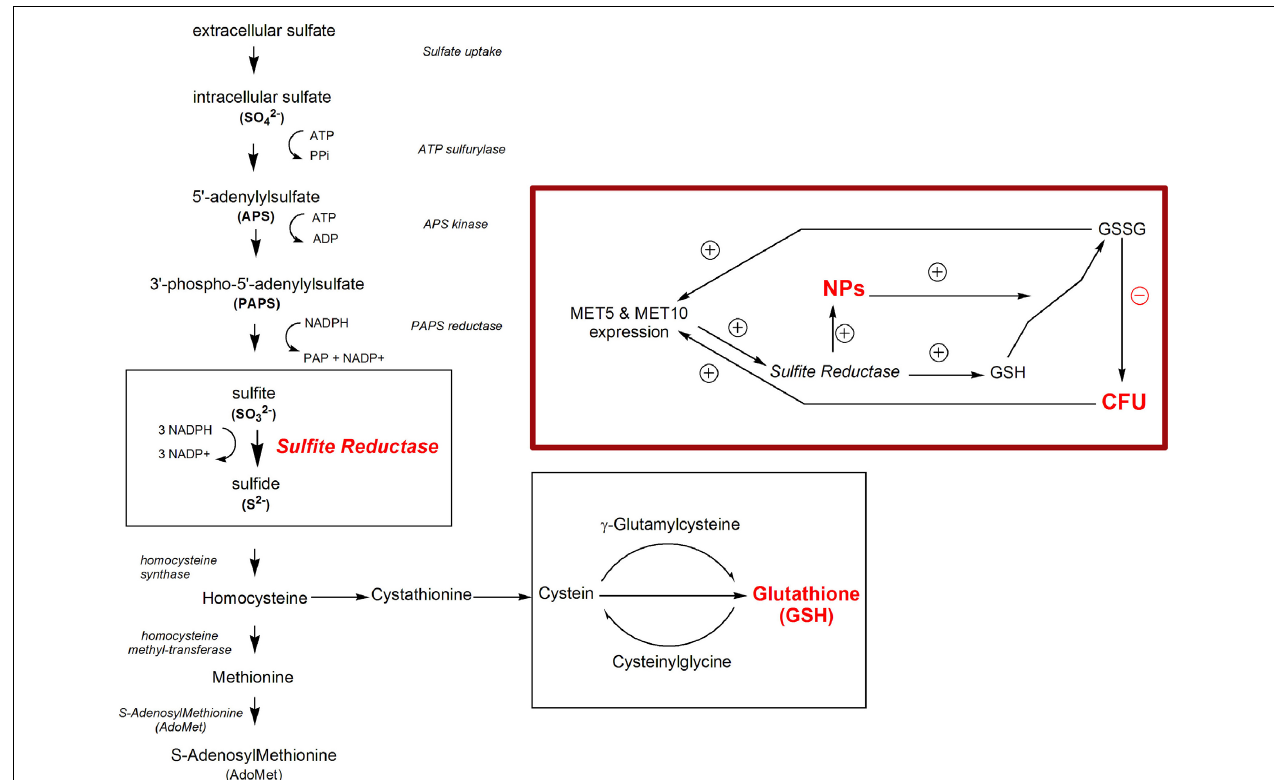
FIGURE 1 | Sulfur pathway in S. cerevisiae . The inset shows the correlation between NPs synthesis, sulfite reductase activity and the expression of sulfite reductase main genes, and MET5 and MET10